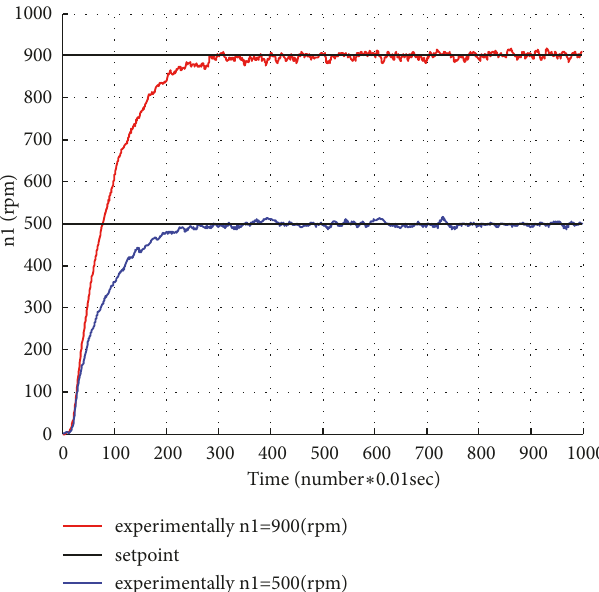
Figure 17: Velocity response of the working shaft at oil temperature of 60 ∘ C.